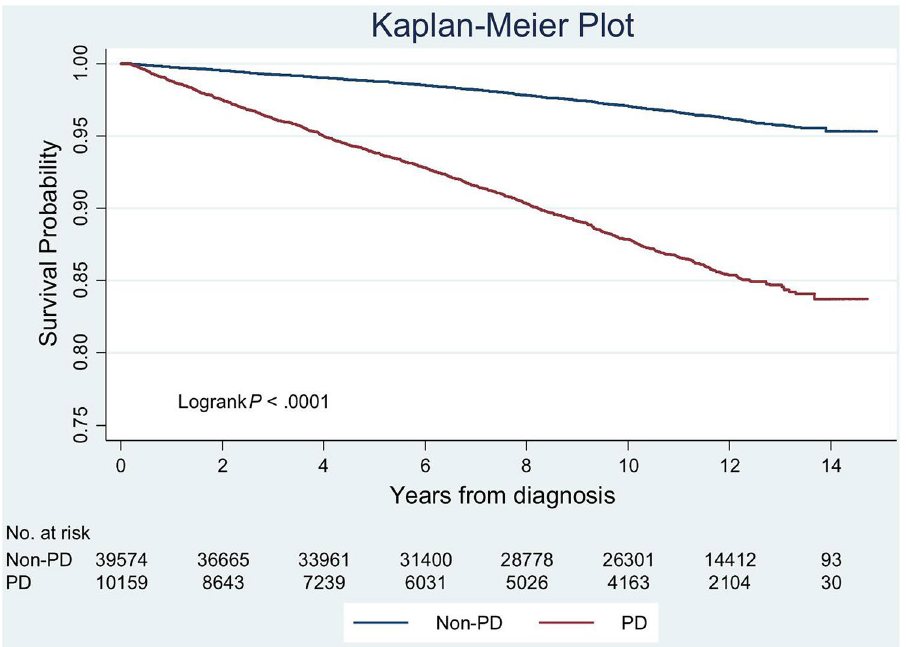
Figure 1. Kaplan Meier analysis for first occurrence of aspiration pneumonia in PD patients and control